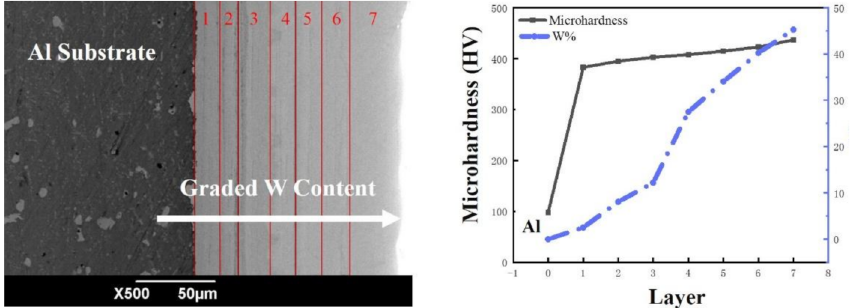
Figure 11. The micro-hardness changes with W content in Ni–W graded coating.